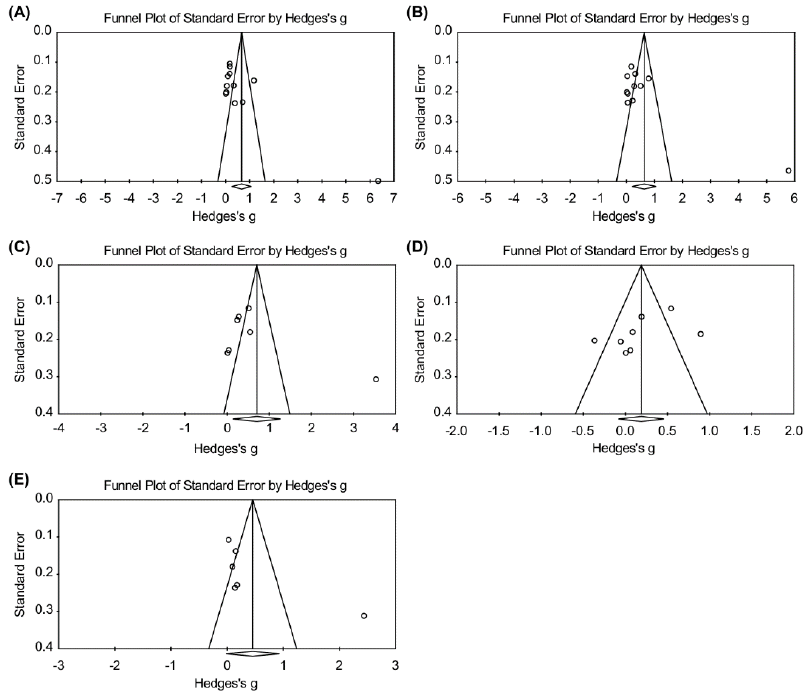
Table 3. Results of publication bias by Egger’s regression test at the final point.